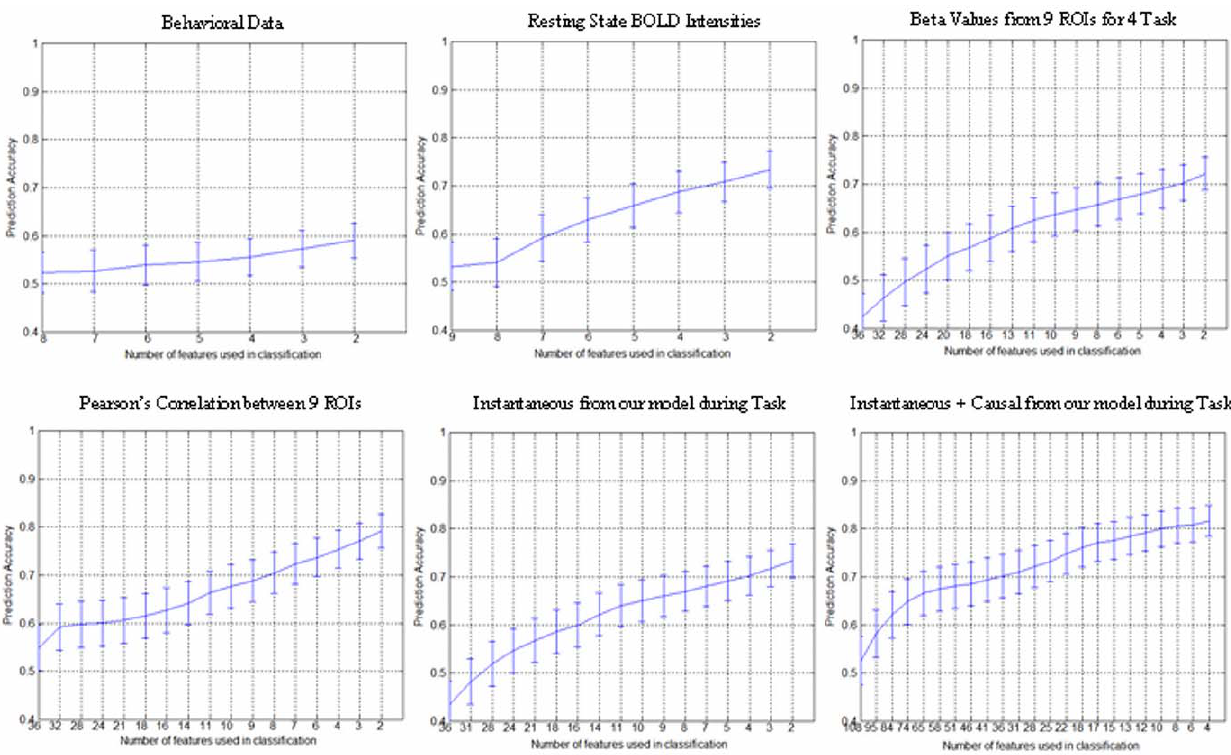
Figure 2. The evolving performance of the RCE-SVM classifier with decreasing number of features derived from: top left- behavioral data obtained from a working memory task with emotional distracters, top middle- resting state BOLD intensities from 9 ROIs, top right- beta values from 9 ROIs for 4 task activation conditions, bottom left- Pearson’s correlation between 9 ROIs during task, bottom middle- instantaneous influence from our model during task, bottom right- instantaneous + causal influence from our model during task.